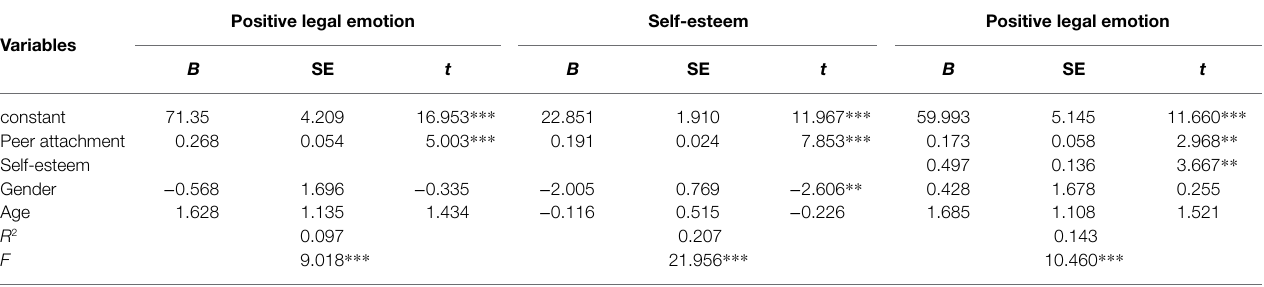
TABLE 3 | Results of multiple regression